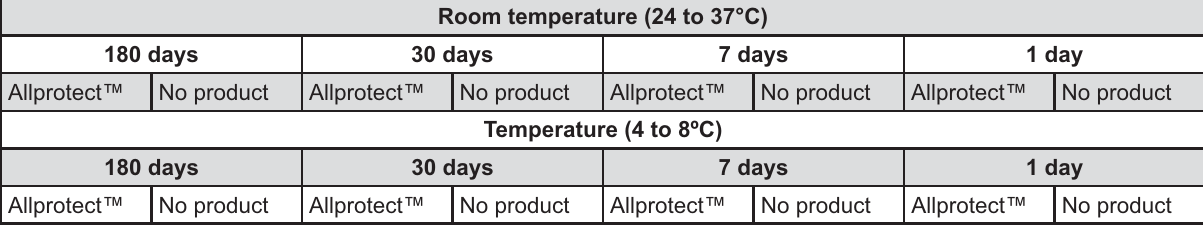
Figure 1- Description of experimental groups